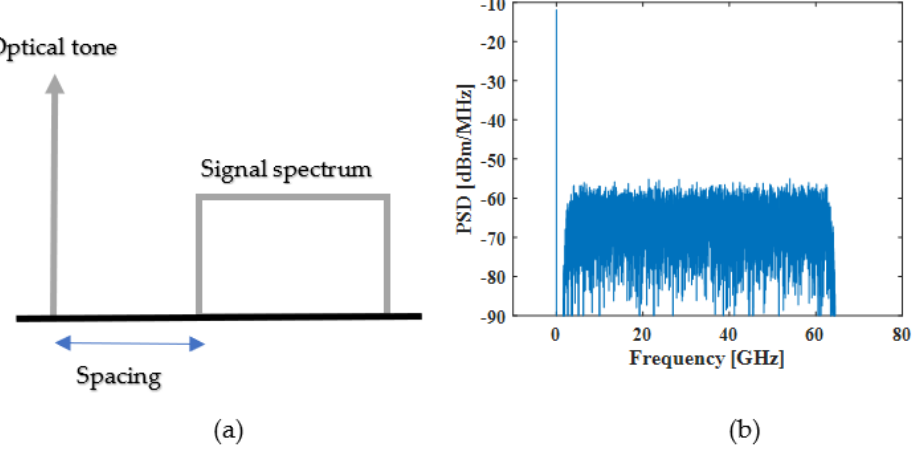
Figure 2. ( a ) Illustrative spectrum of the signal at the transmitter output. ( b ) Power spectral density obtained by simulation of the signal at the transmitter output.